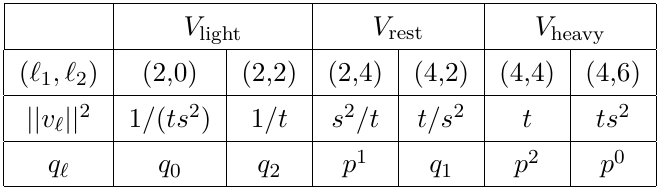
Table 2. Limit II 1 → IV 2